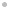
Standardized (Cohen’s d) differences of the technical and creative components performance between the control and experimental groups (grey ⦁ dots represent U15 age groups, while the ▲ black triangles represent the U17 age groups).Error bars indicate uncertainty in the true mean changes with 90% confidence intervals. Light grey zone reflects trivial values. Values towards the right means higher values for the experimental group, while higher values towards the left means higher values for the control group. N: number of actions.